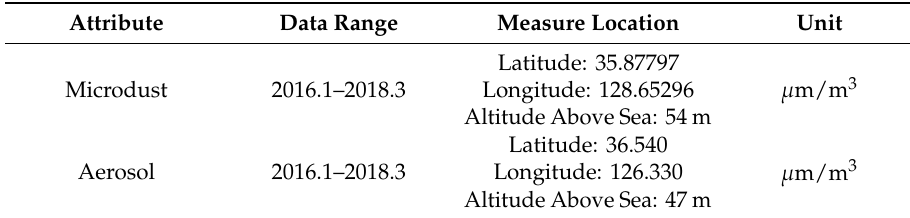
Table 3. Aerosol data